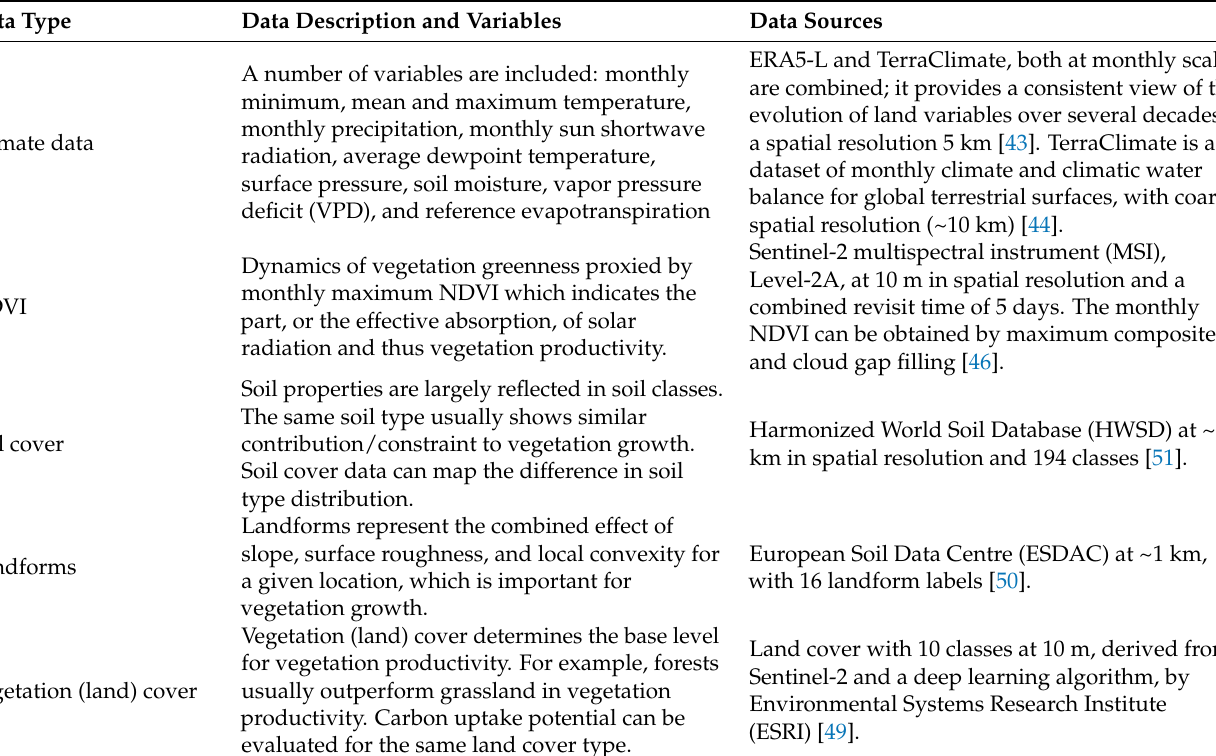
Table 2. Data description and data